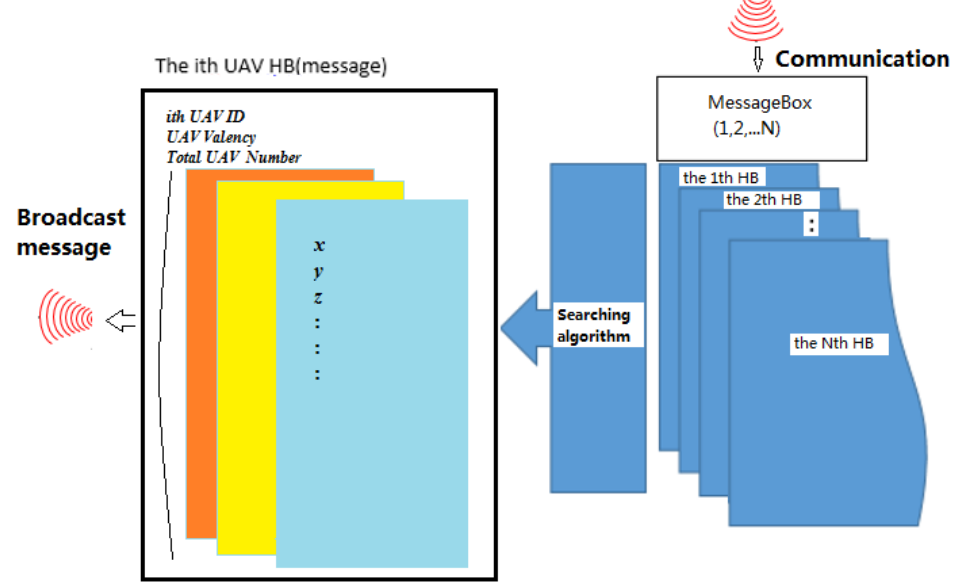
Figure 1. Information fusion. HB: